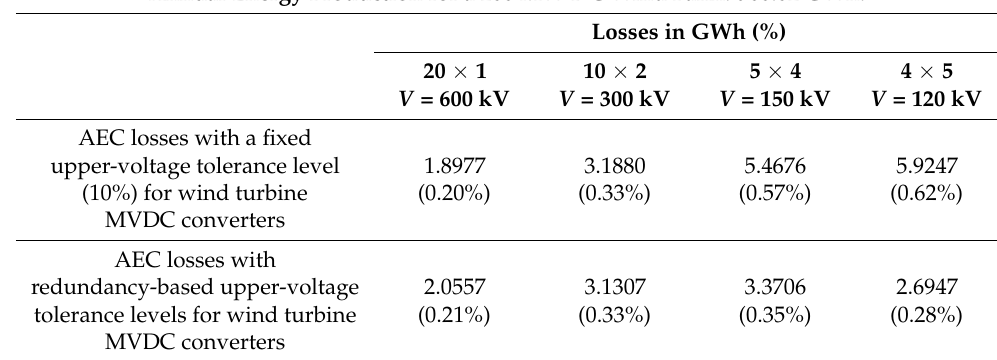
Table 4. Evaluation and comparison of AEC losses (using 25% reduction in string